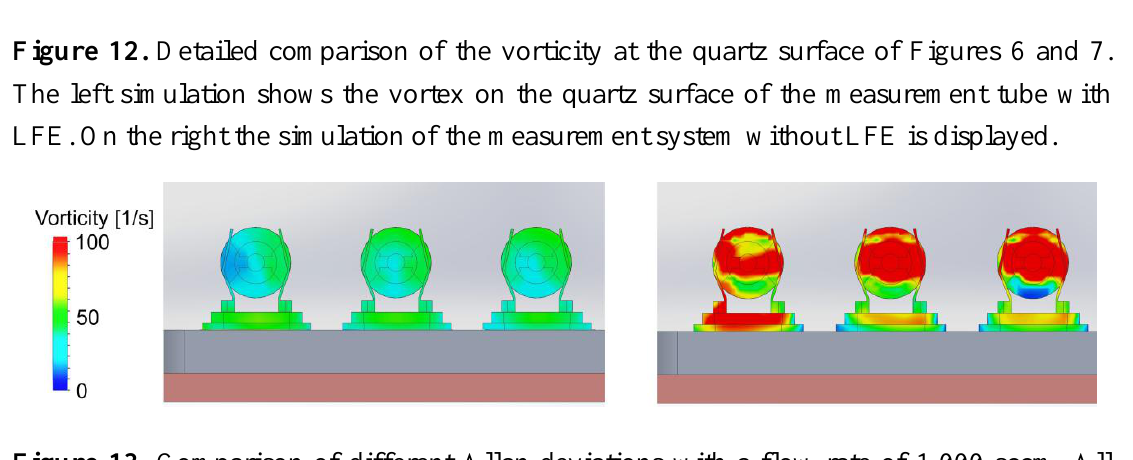
Figure 13. Comparison of different Allan deviations with a flow rate of 1,000 sccm. All measurement were taken at least 4 h after the device